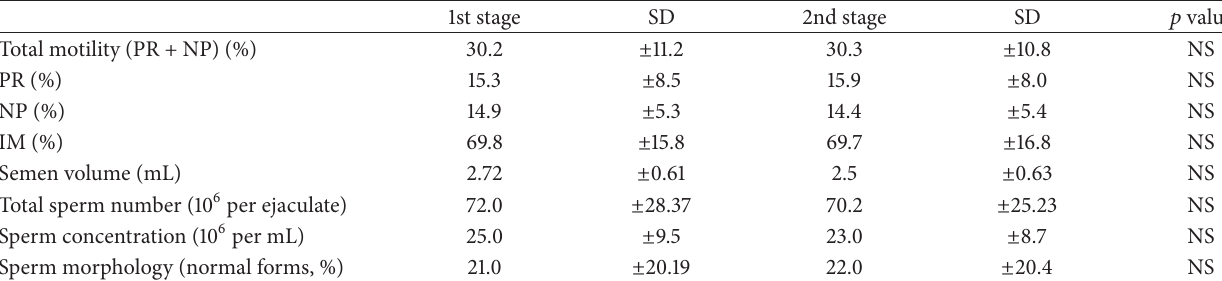
Table 2: Sperm parameters by spermiogram.